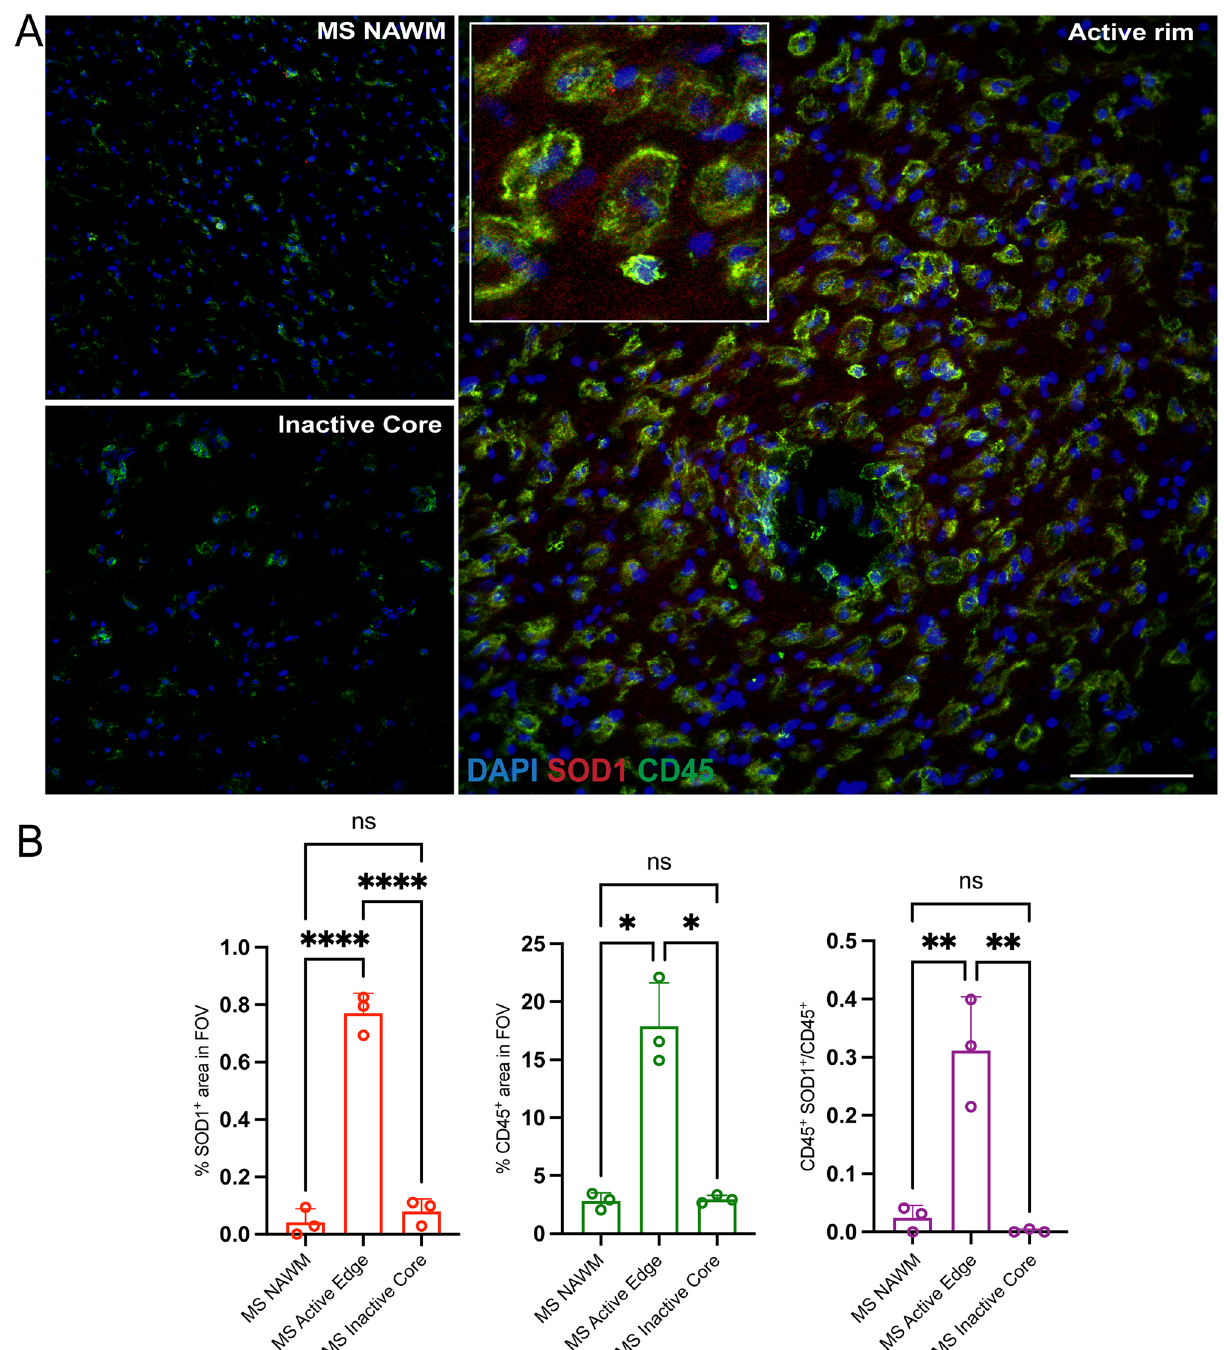
Figure 6. Expression of SOD1 antioxidant enzyme is elevated in the chronic active rim of MS lesions. ( A ) Representative confocal images of NAWM, inactive Core, and active rim of an MS lesion labeled with CD45 for immune cells (green), SOD1 (red) and DAPI (blue). ( B ) Bar graphs comparing the percent of field of view (FOV) that is CD45 + , SOD1 + , and CD45 + SOD1 + . Scale bar = 100 µm. Data are shown as mean ± S.D, n = 3 MS patients. Significance indicated as * p < 0.05, ** p < 0.01, *** p < 0.001, **** p < 0.0001, One-way ANOVA with Tukey’s post-hoc